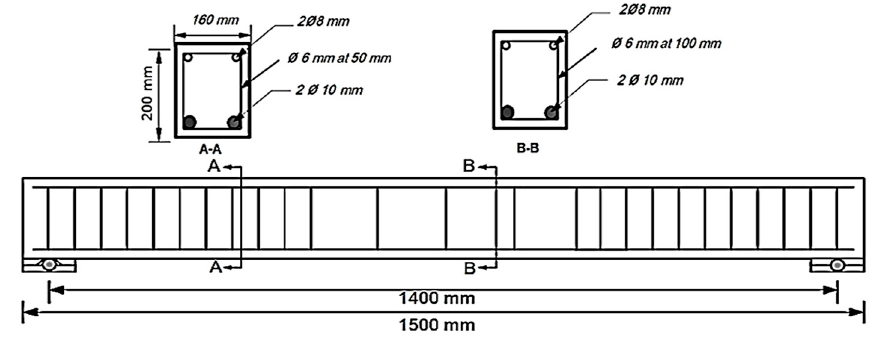
Figure 1. Concrete geometry and reinforcement details of tested specimen. Table 1. Designation and details of tested members.